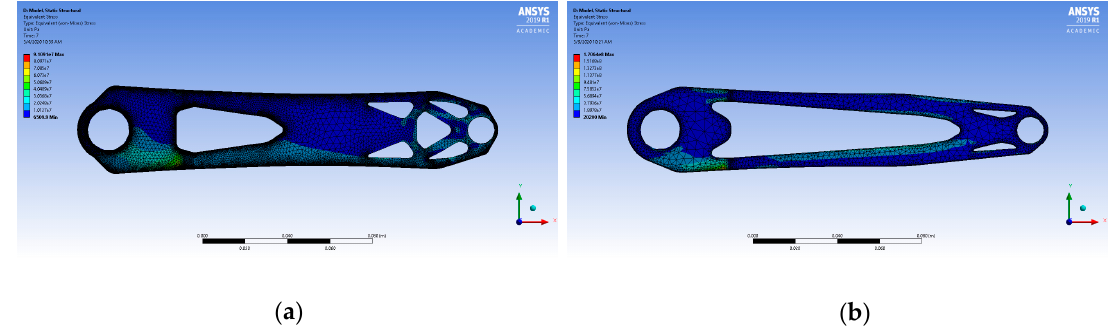
Figure 14. Effect of material: (a) Aluminum alloy, (b) carbon fiber.